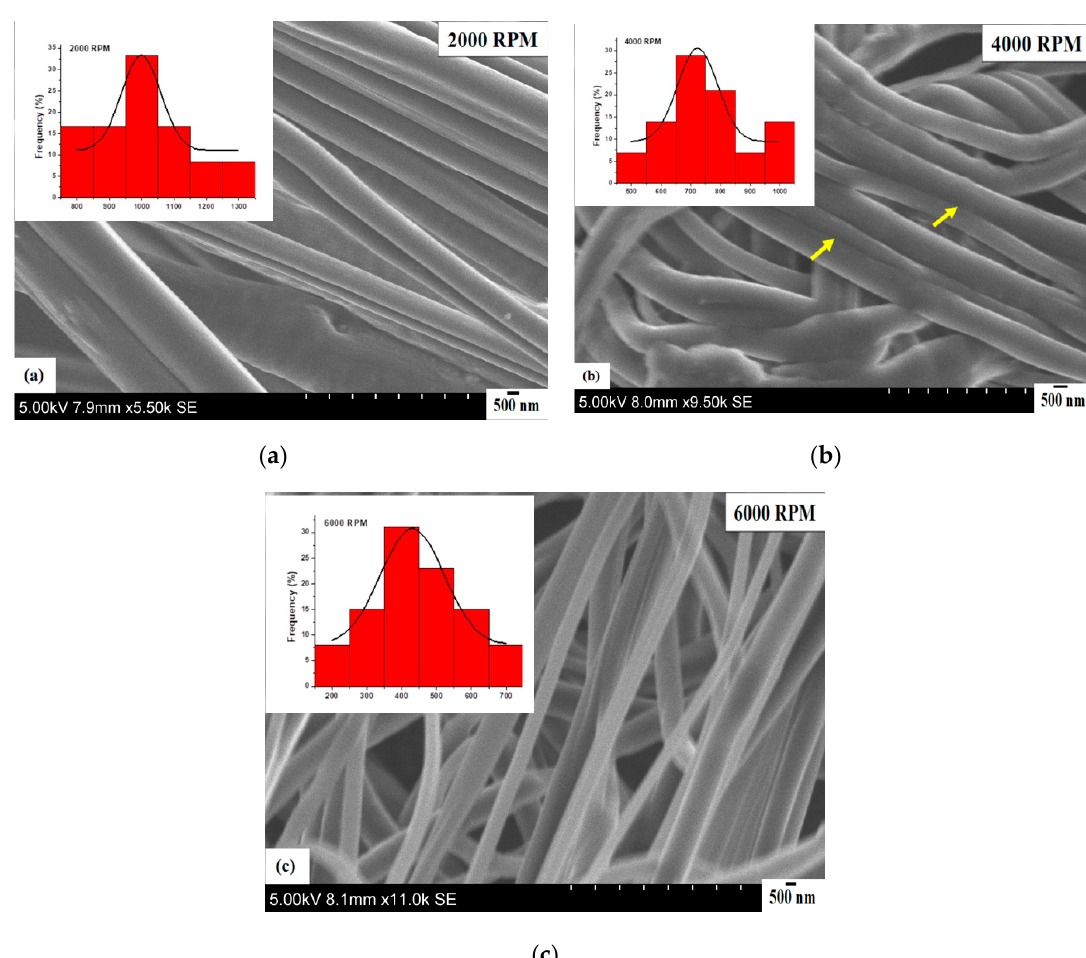
Figure 4. Scanning electron micrographs of core–sheath nanofibers obtained at a constant working pressure of 0.1 MPa and different rotating speeds ( a ) 2000 RPM ( b ) 4000 RPM ( c ) 6000 RPM. Insets show the corresponding fibre size distributions of core–sheath nanofibers for each case.